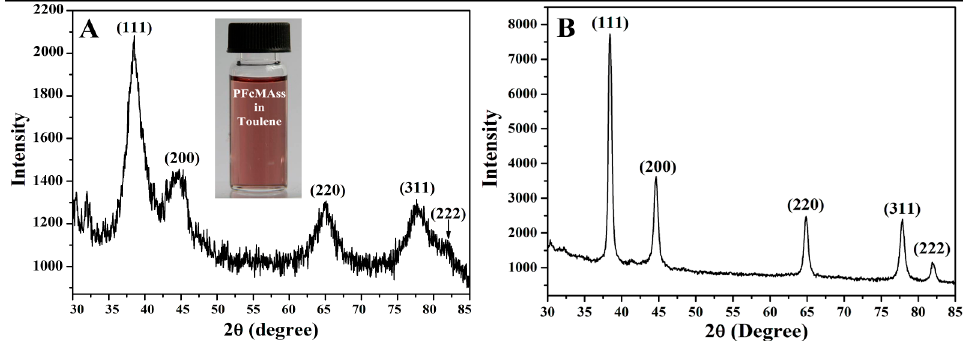
Figure 5. XRD pattern of PFcMAss-functionalized AuNPs ( A ) and GO-PFcMAss-AuNPs ( B ).